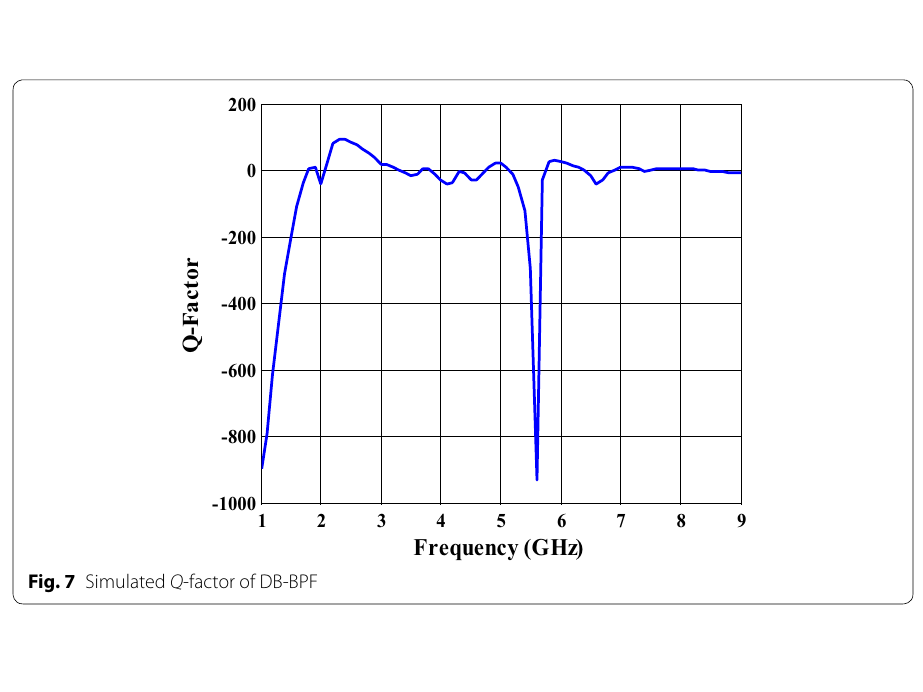
The prototype realization of top and bottom surface of DB-BPF is displayed in Fig. 9. The insertion and return loss readings of filter prototype are studied using net- work analyzer, Model HP8757D, and compared with simulated outcomes, as shown in Figs. 10 and 11, respectively. A decent agreement prevails between simulated as well as measured outcomes. The proposed DB-BPF has bandwidth (from 2 to 7.8) GHz at 10 dB line with a stop band between 3.8 and 4.3 GHz (0.5 GHz) with fractional − bandwidth of 120% calculated from bandwidth and resonant frequency.